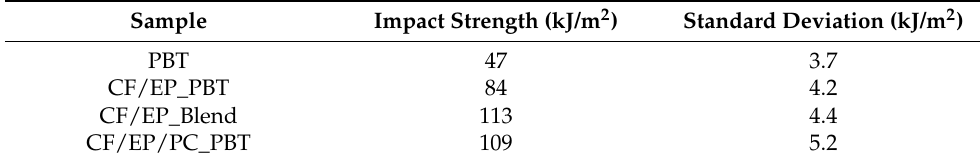
Table 3. Charpy unnotched impact strength of the investigated materials.